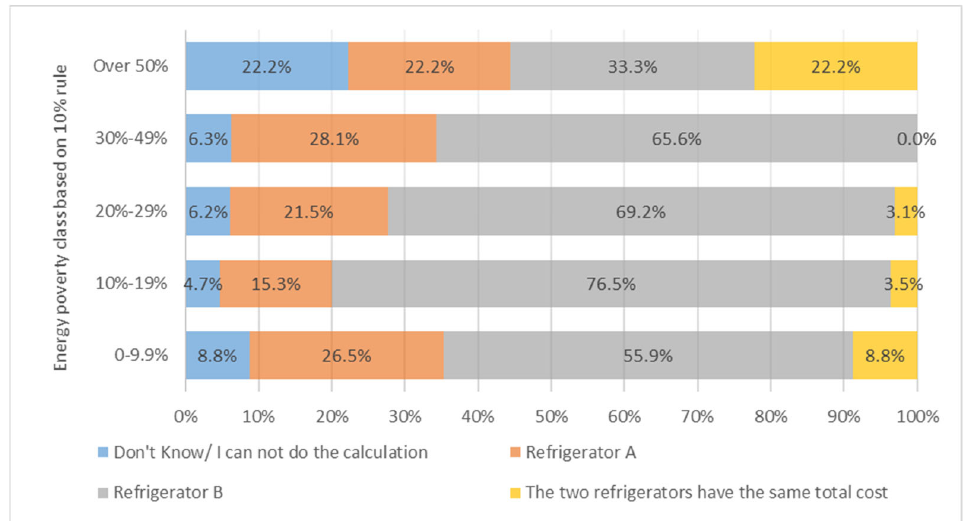
Figure 15. Energy ‐ related financial literacy investigation by energy ‐ vulnerable and non ‐ vulnerable Figure 15. Energy-related financial literacy investigation by energy-vulnerable and non-vulnerable households—“ten percent rule” indicator. households—“ten percent rule”